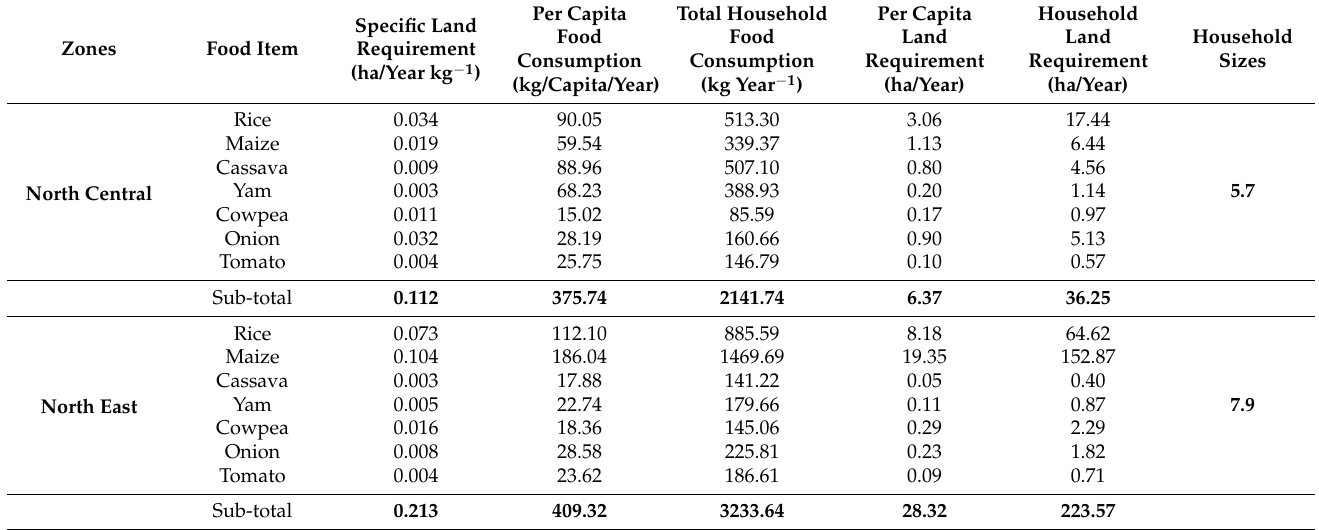
Table 4. Land requirements per food item based on food quantity consumption in the 6 geopolitical